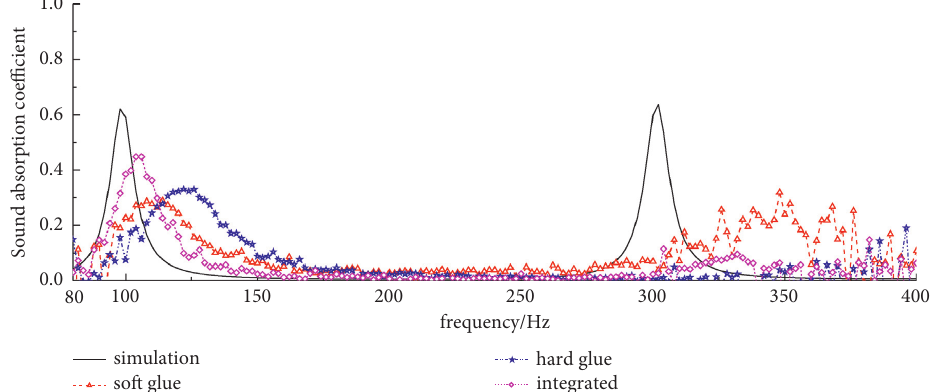
Figure 16: Comparison of experimental results and simulation